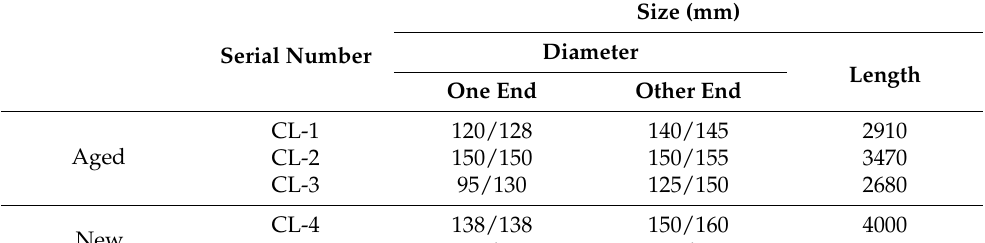
Table 1. Dimensions of the log samples.